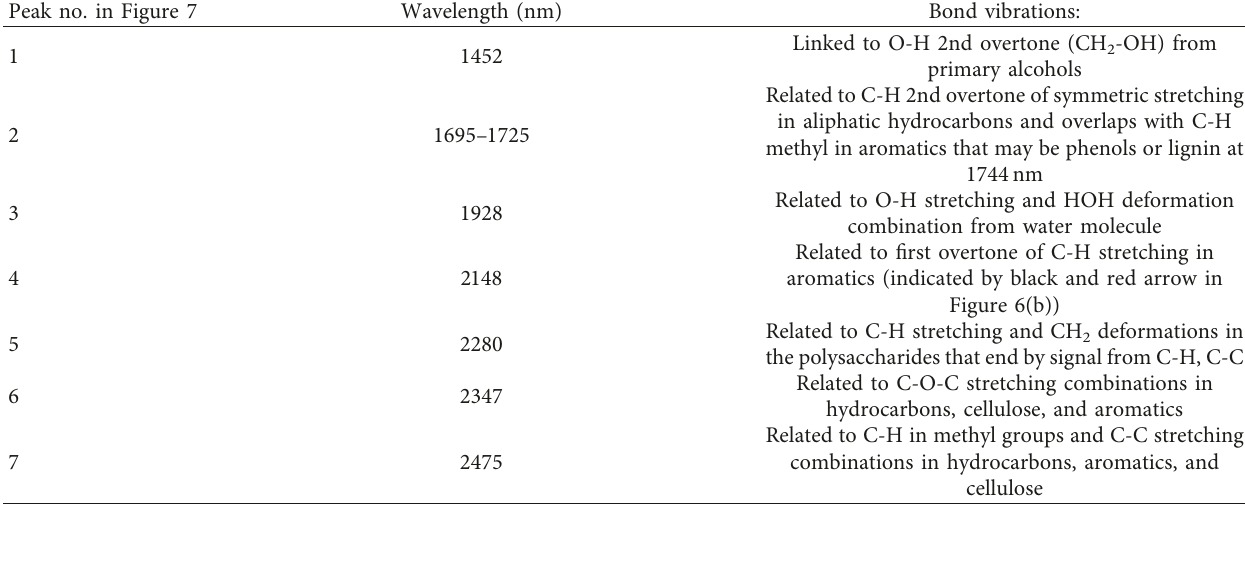
Table 3: Band assignment for the average spectrum of naturally seasoned and kiln-dried wood. Peak no. in Figure 7